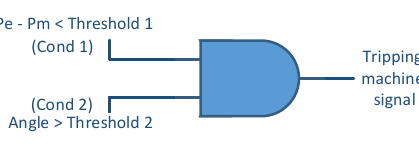
Figure 3. Generator tripping